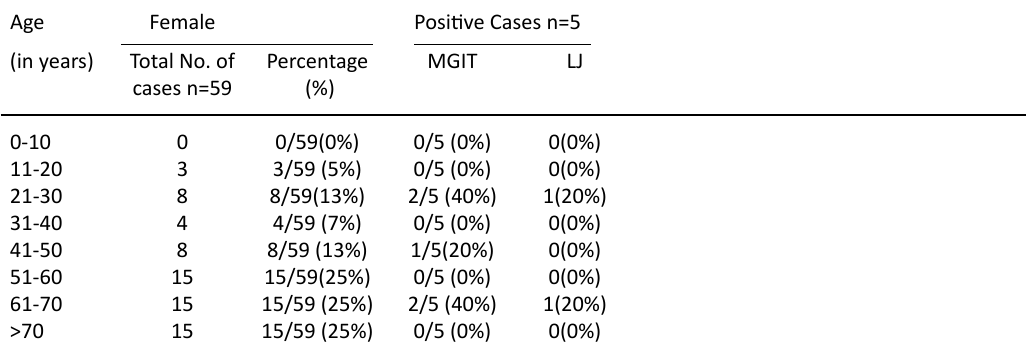
Table 4 (b). Gender wise distribution of cases (female) (n=59)